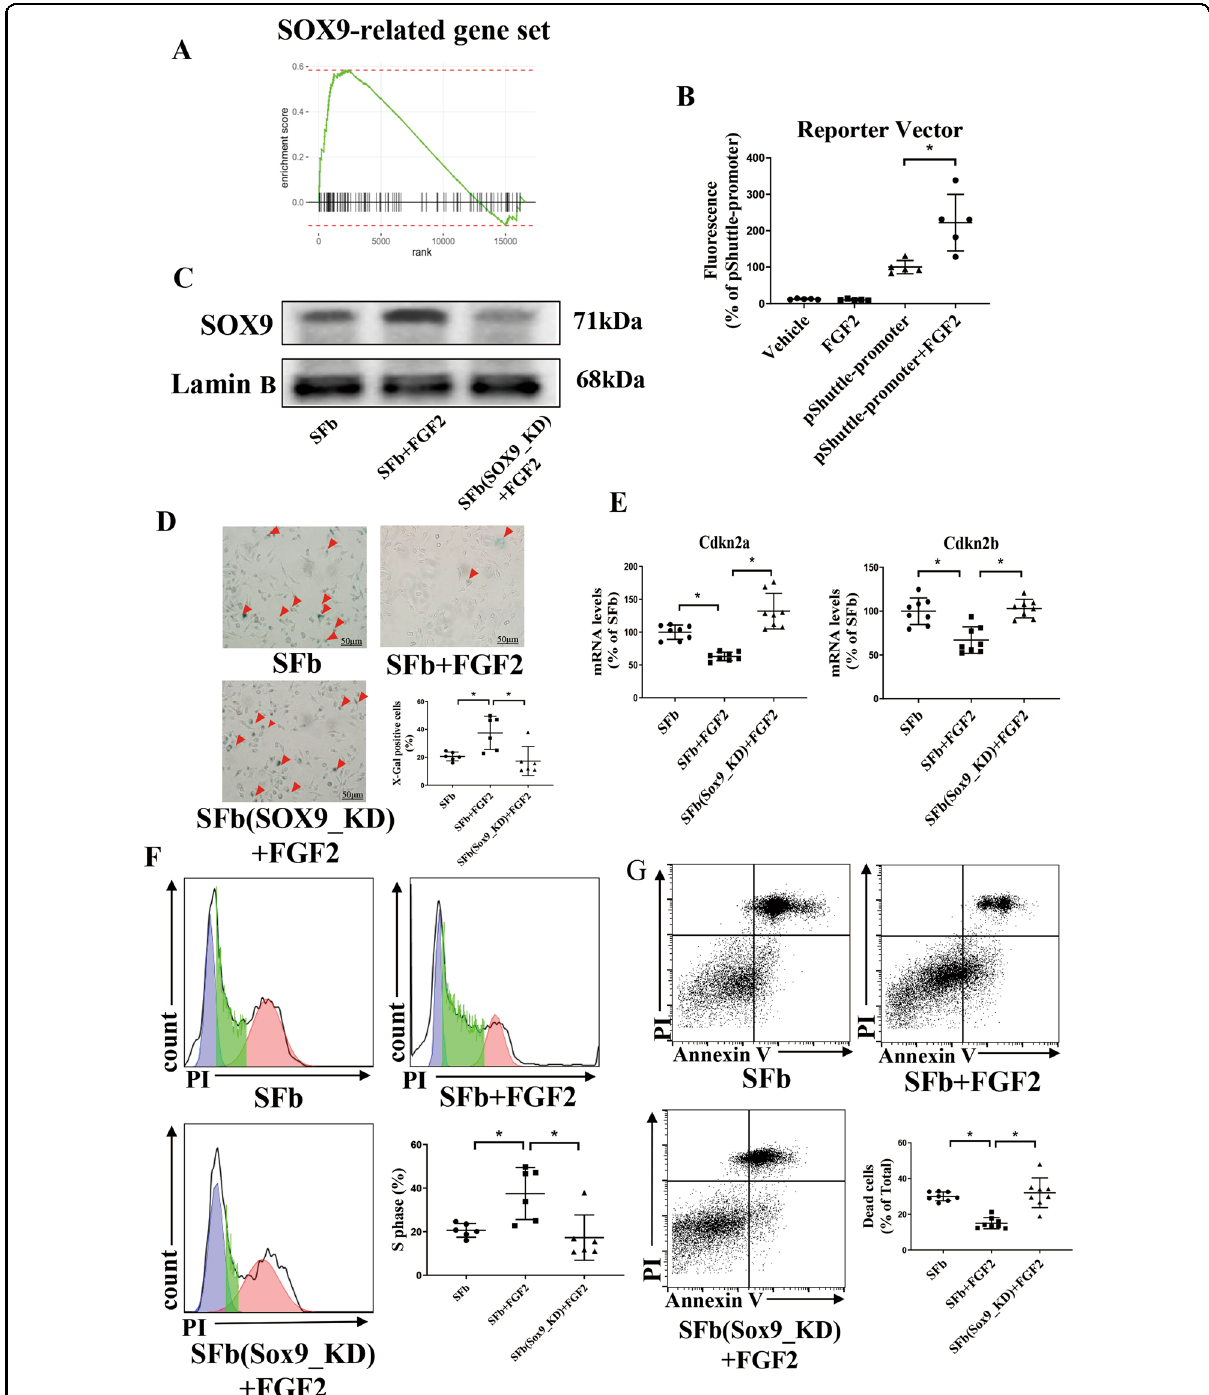
Fig. 6 The pro fi brotic factor SOX9, induced by FGF2 elevation, is required for G-MDSC-mediated suppression of senescence and apoptosis. A GSEA showing the SOX9-related gene set enriched in the fi broblasts treated with FGF2. B Luciferase activity driven by the SOX9 motif in the fi broblasts treated with FGF2. An asterisk indicates a signi fi cant difference vs. the pShuttle promoter; n = 5 per group. C – G The fi broblasts with SOX9 knockdown in vitro were cultured with medium supplemented with FGF2 (4ng/mL) for 24h. C Western blotting analysis showing the expression level of SOX9 in senescent fi broblasts. D Representative X-gal staining images (top) and statistical data (bottom) on fi broblast senescence; n = 6 per group. Scale bars, 50 μ m. E The mRNA levels of the senescence markers Cdkn2a and Cdkn2b in senescent fi broblasts; n = 8 per group. F Cell cycle distribution and the percentage of fi broblasts in S phase were detected by fl ow cytometry through PI staining; n = 6 per group. G Representative fl ow cytometric images and statistical data of apoptosis rates of senescent fi broblasts determined by Annexin V-FITC and PI staining; n = 8 per group. The data are presented as the means±SDs. Differences were determined by one-way ANOVA (more than 2 groups), and Tukey ’ s HSD post hoc test was performed. * P